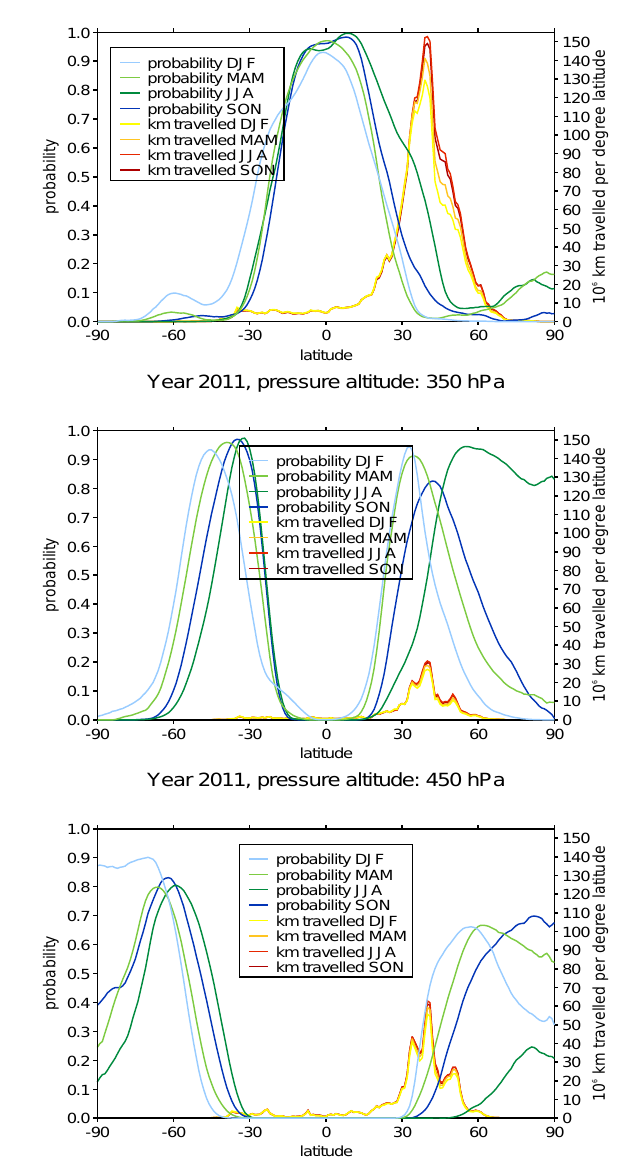
Fig. 5. Seasonal variation of zonally averaged probability that an aircraft with ∆ p = 50 hPa produces an aerodynamic contrail when flying on the indicated pressure level, 250, 350, and 450 hPa (from top to bottom). Only temperature criteria are considered for this figure. Furthermore the seasonal and latitudinal distribution of air traffic at about the indicated pressure level is shown in the figure.